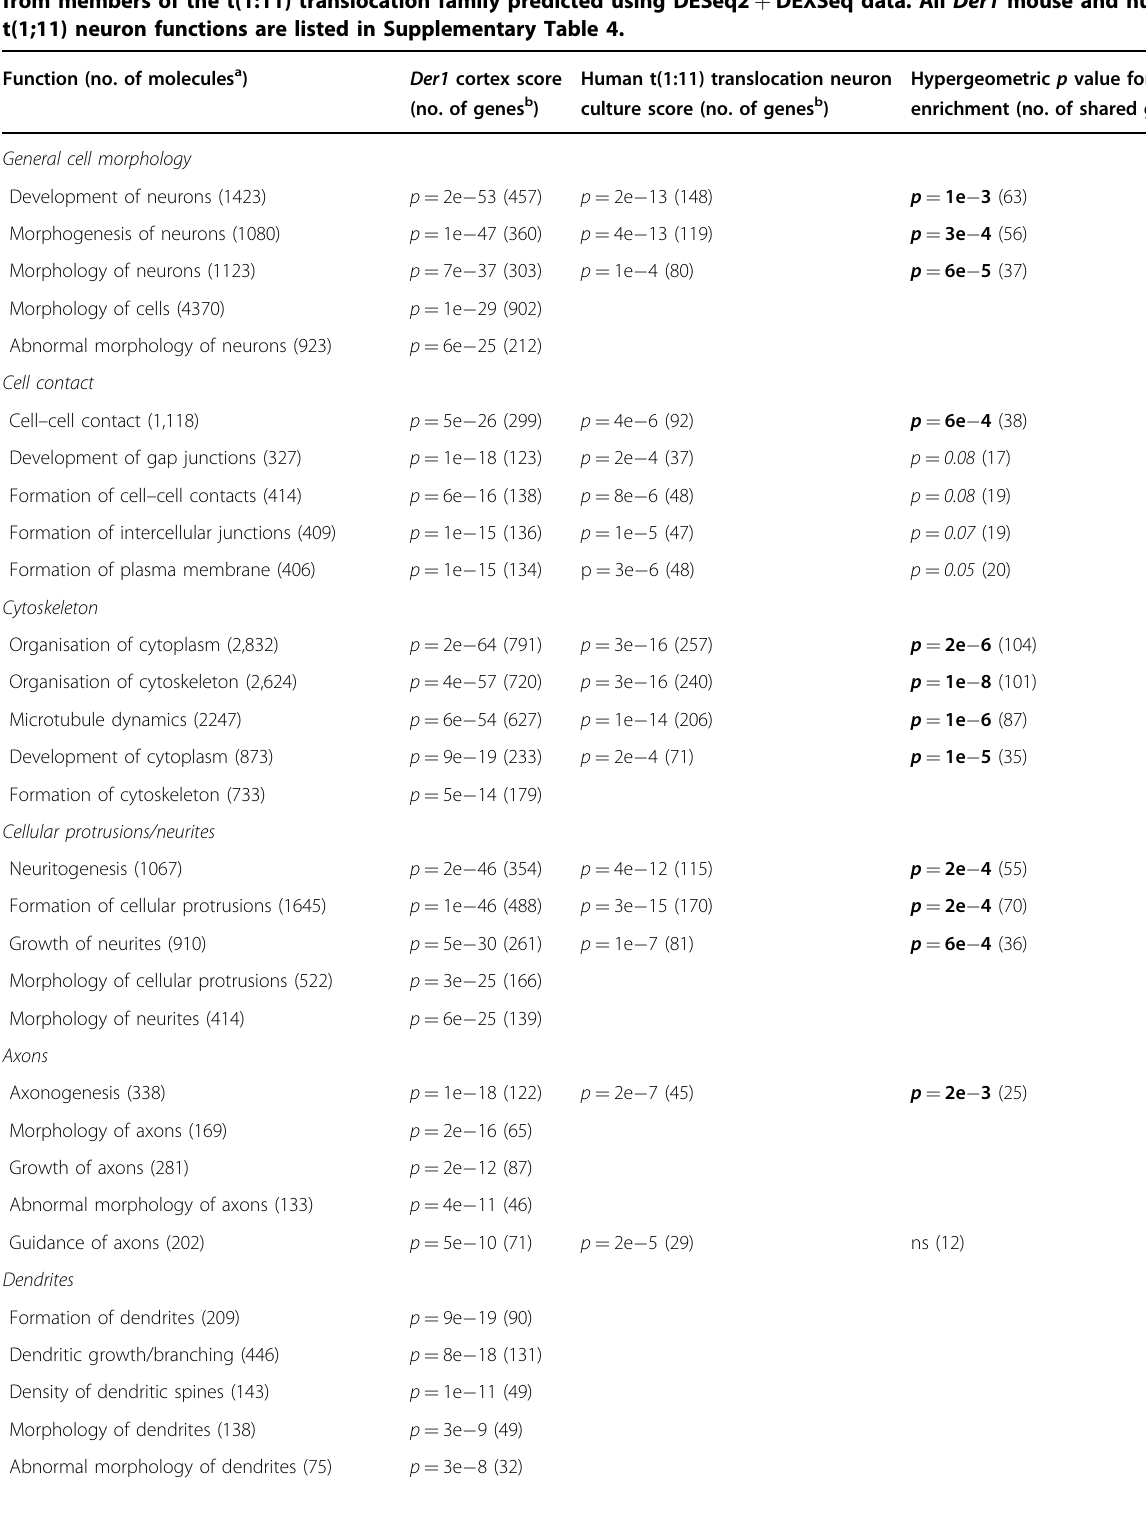
Table 1 Top relevant altered cellular functions in heterozygous Der1 mouse cortex and human iPSC-derived neurons from members of the t(1:11) translocation family predicted using DESeq2 + DEXSeq data. All Der1 mouse and human t(1;11) neuron functions are listed in Supplementary Table